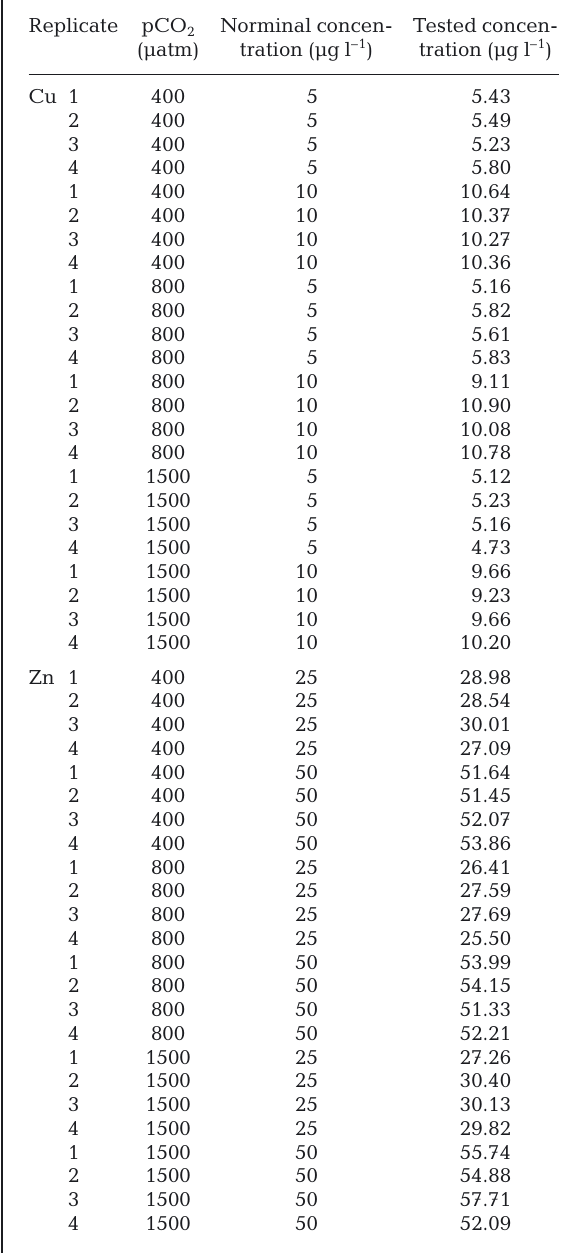
Table A1. Cu and Zn concentrations of test solutions used in experiments testing larval deformation and shell length in Crassostrea